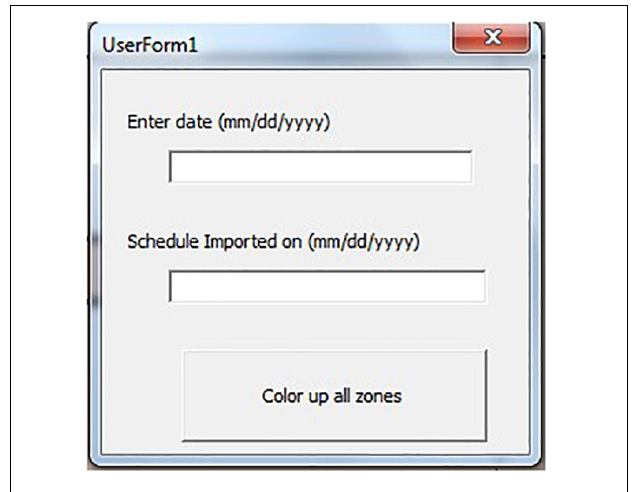
FIGURE 9 | LoSite window for date input in step